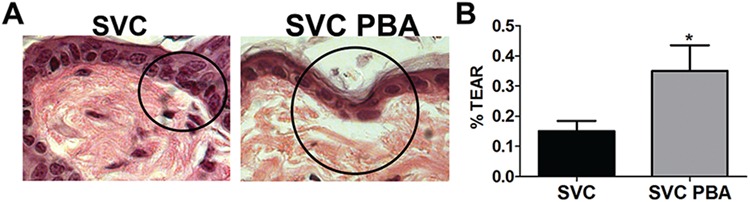
PBA does not improve BM strength. (A) PAS stain of tissue section from Col4a1+/SVC and 1-month treated Col4a1+/SVC (SVC PBA), which shows separation of dermis from epidermis (circle). (B) ImageJ analysis revealed increased separation in treated mice (SVC n = 7, SVC PBA n = 4) unpaired t-test *P < 0.05 (Stain of WT littermate is provided in Supplementary Material, Fig. S8).